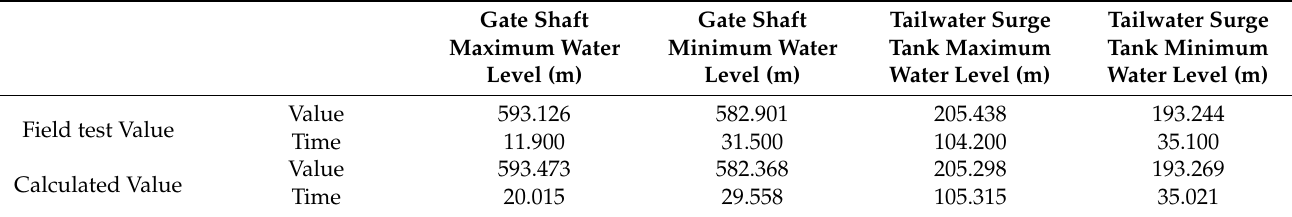
Table 2. Comparison results of simulation and field test.